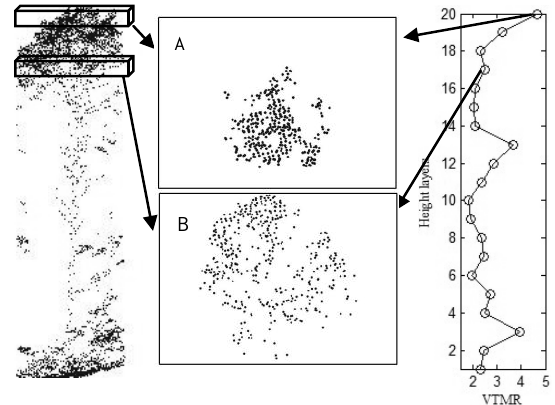
Figure 1. Left: point cloud of an aspen tree. Middle: projected point cloud of two example layers. Right: calculated VTMRs of the 20 height layers.